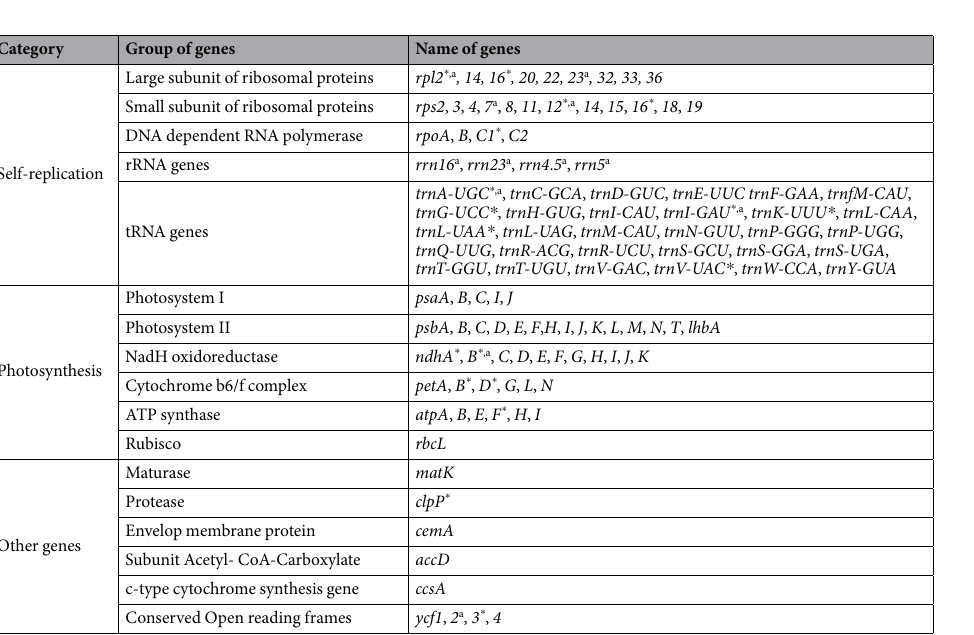
Figure 2. Gene contents of the A . halleri ssp. gemmifera and A . lyrata ssp. petraea chloroplast genomes, grouped by gene family. The colour of each gene is unique within its gene family. Horizontal axis indicates each box is proportional to the size of the gene (bp), including introns.